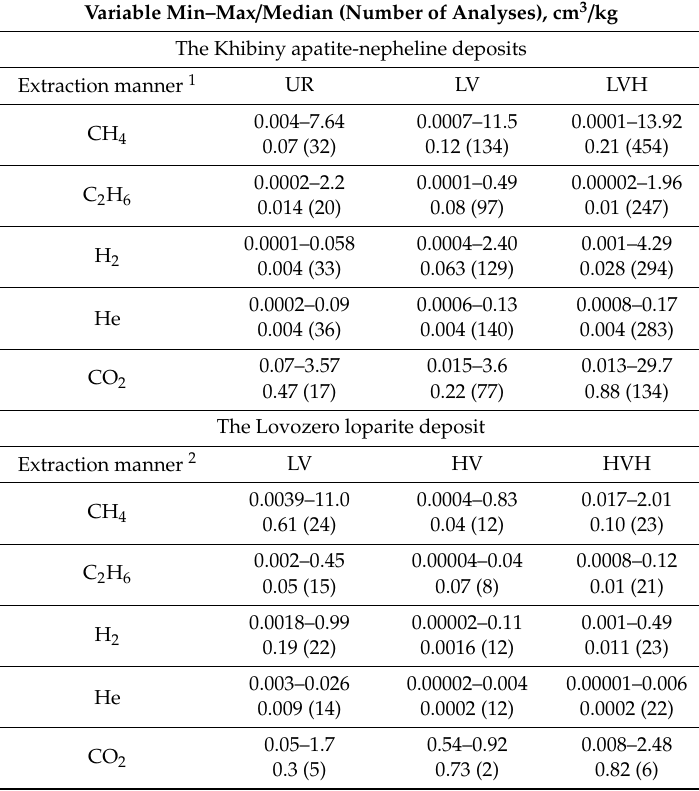
Table 2. Composition of di ff usely dispersed gases calculated as an air-free mix of continuously present components (the selection with recalculation from